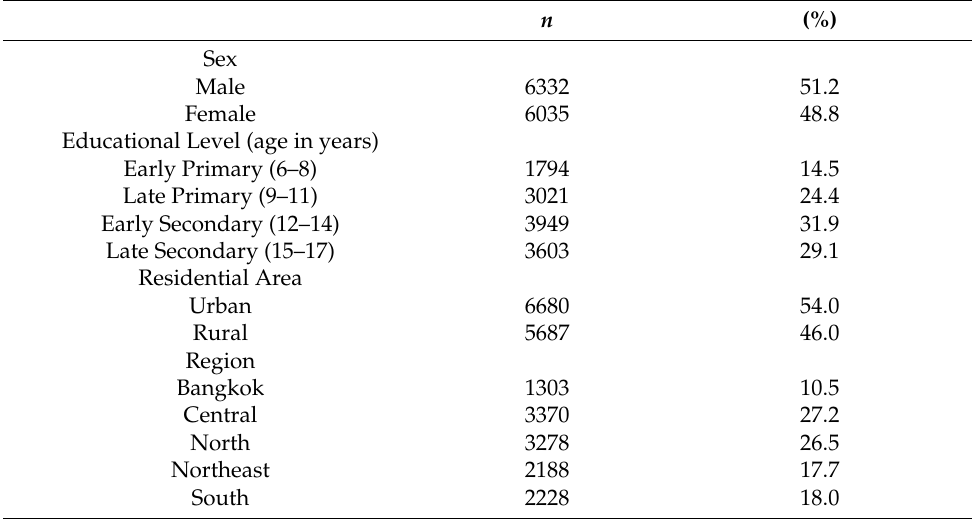
Table 1. Characteristics of the